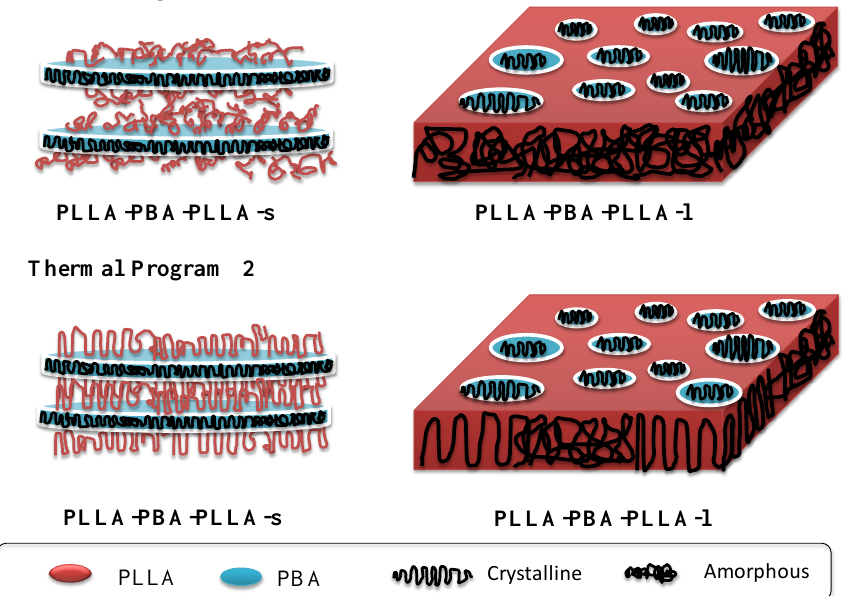
Figure 8. A scheme showing the resultant microstructures of PLLA-PBA-PLLA triblock copolymers under thermal programs 1 and 2,